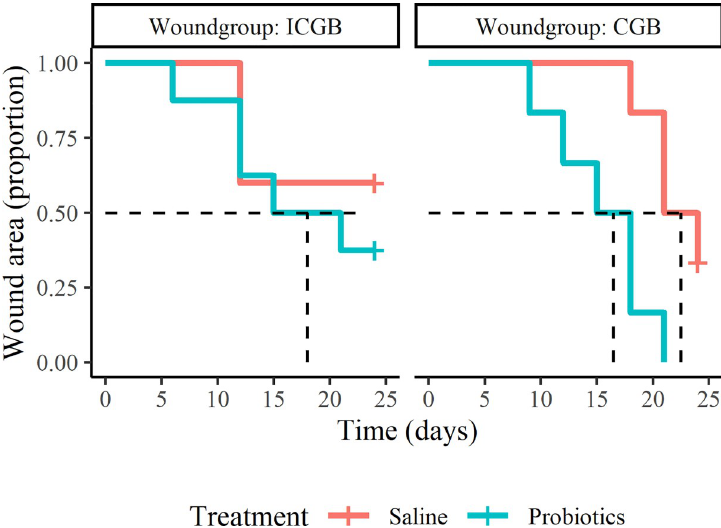
Fig 3. Kaplan-Meier graph showing the proportion of wounds with a wound area of more than 50 percent of the initial wound area. ICGB = group with incomplete granulation bed, CGB = group with complete granulation bed. The dashed line (- -) indicates the median time when the wounds have reached at least 50% healing of the initial wound